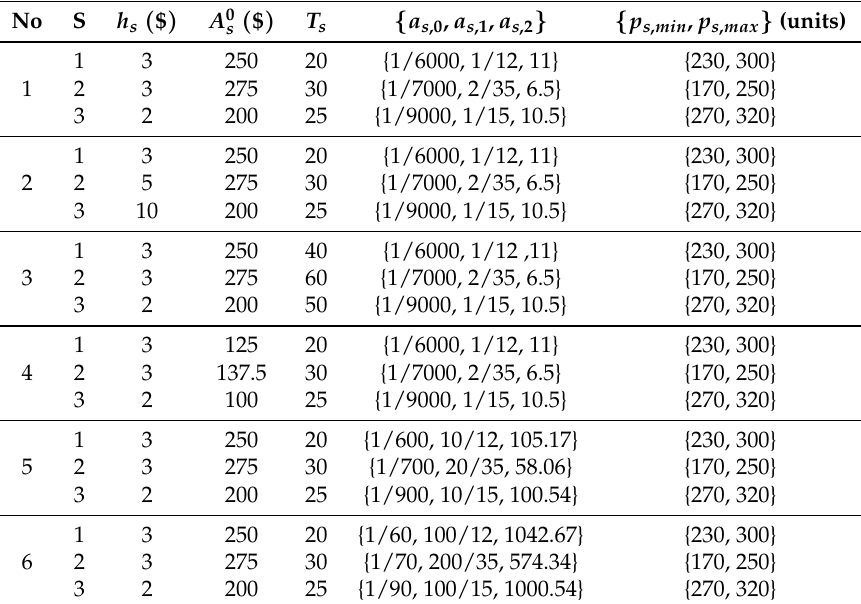
Table 2. Test problems used for computational experiments.